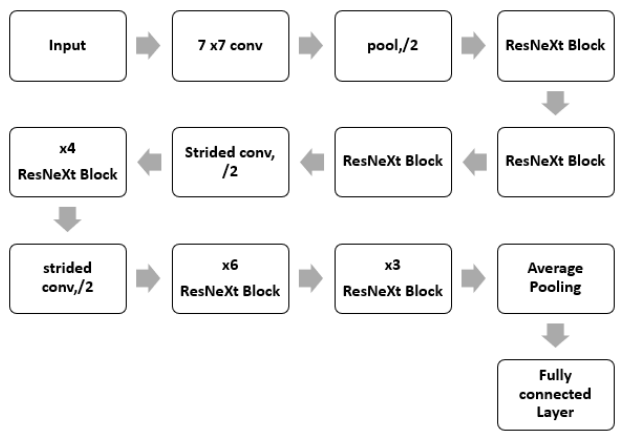
Figure 5. ResNeXt Architecture.